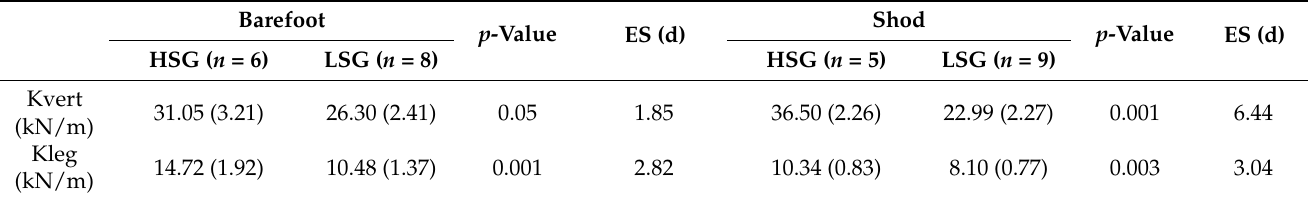
Table 2. Leg and Vertical lower-limb stiffness in barefoot and shod conditions (ANOVA).